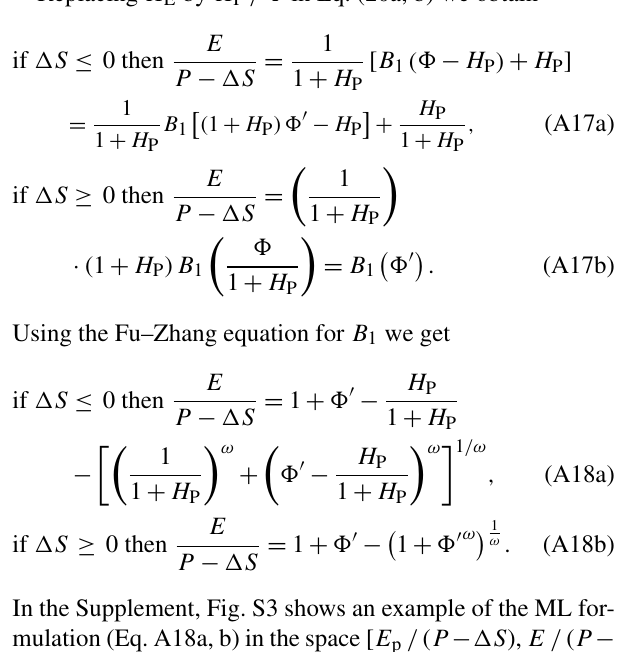
sponds to Fig. 4 obtained with H E = − (cid:49)S / E p . Table S4 in ferent Budyko curves of Table 1 in the space [ E p / ( P − (cid:49)S ), E / ( P − (cid:49)S )] with the parameter H P (Eq. A17a and b). It corresponds to Table S2 in the Supplement obtained with H E